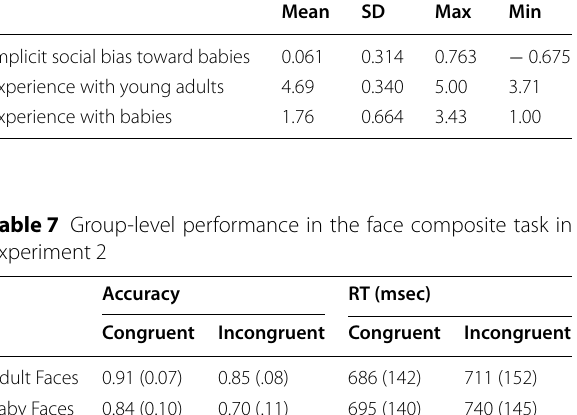
Table 8 Correlations among the dependent measures and predictors in Experiment 2